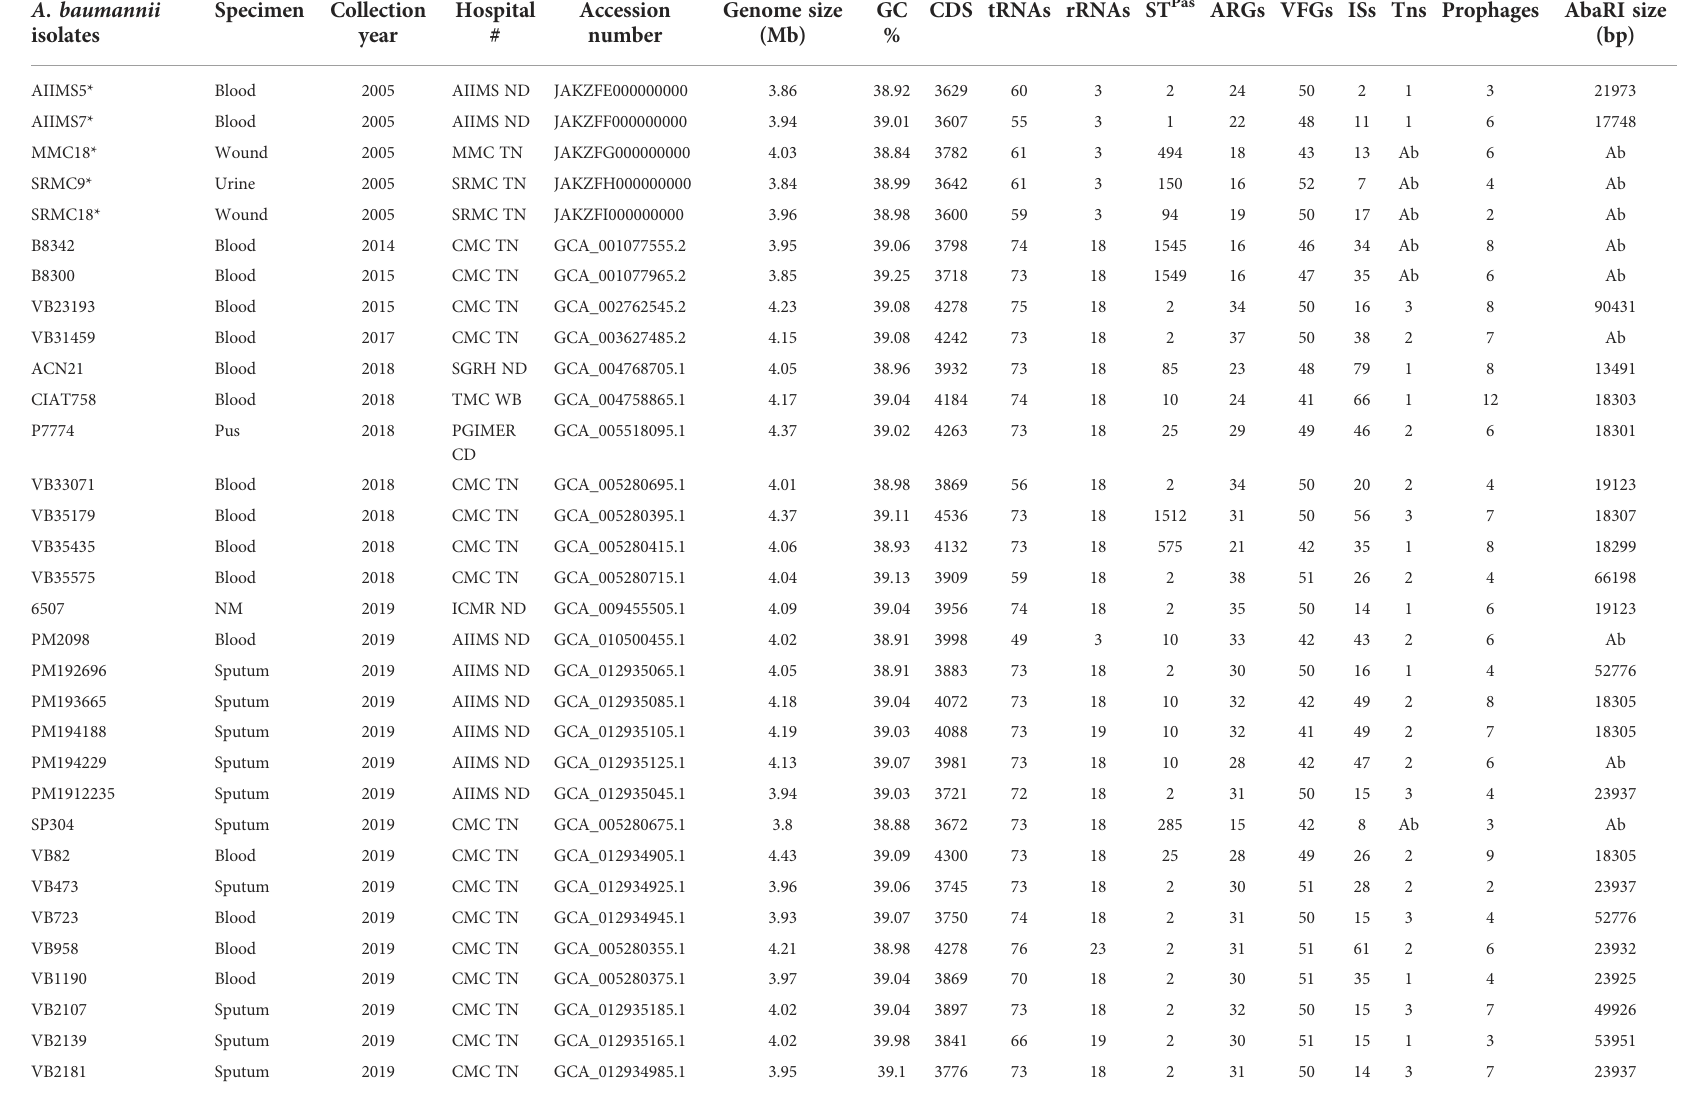
TABLE 1 The general details and genomic features of 47 Indian A. baumannii analyzed in the study. A.